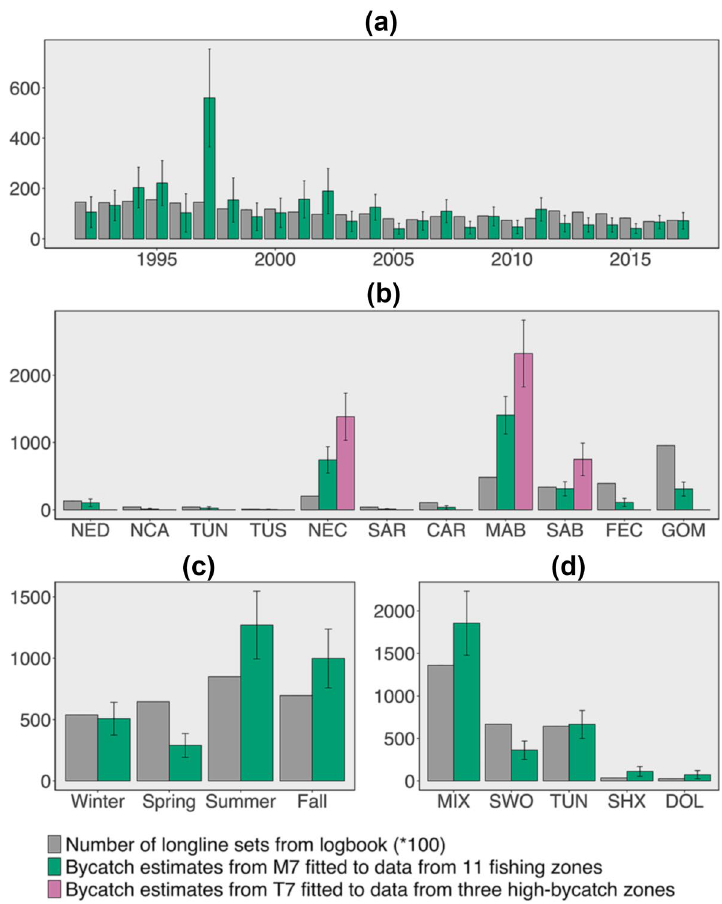
Figure 6. ( a ) Annual number of longline sets from logbook and seabird bycatch estimates (in number) for all 11 fishing areas from 1992 to 2017 from model M7 fitted to data from 11 fishing zones. ( b ) Number of longline sets from logbook and seabird bycatch estimates (in number) by area from 1992 to 2017. Abbreviations represent the following: NED – Northeast district, NCA – North Central Atlantic, TUN – Tuna North, TUS – Tuna South, NEC – Northeast coast, SAR – Sargasso region, CAR – Caribbean region, MAB – Mid-Atlantic bight, SAB – South Atlantic bight, FEC – Florida east coast, GOM – Gulf of Mexico. ( c ) Number of longline sets from logbook and seabird bycatch estimates (in number) by season for all 11 fishing areas from 1992 to 2017 from model M7 fitted to data from 11 fishing zones. ( d ) Number of longline sets from logbook and seabird bycatch estimates (in number) by target species for all 11 fishing areas from 1992 to 2017 from model M7 fitted to data from 11 fishing zones. Abbreviations represent the following: MIX – mixed species, SWO – swordfish ( Xiphias gladius ), TUN – tuna ( Tunnus spp.), SHX – pelagic sharks (various Selachimorpha), DOL – dolphinfish ( Coryphaena hippurus ). Error bars are standard deviations. Plot is made using R package ggplot2 (version 3.3.2, https:// ggplo t2. tidyv erse. org) in statistical program R (version 3.6.3, http:// www.R- proje ct.